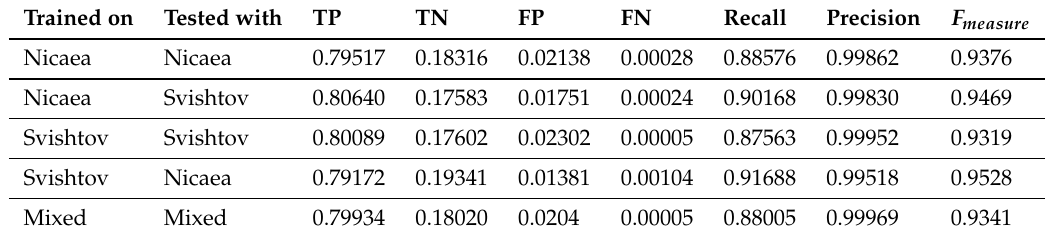
Table 4. True positive, true negative, false positive, false negative, precision, recall, and F measure results are presented for five different models. The results are obtained for populated place objects versus background.